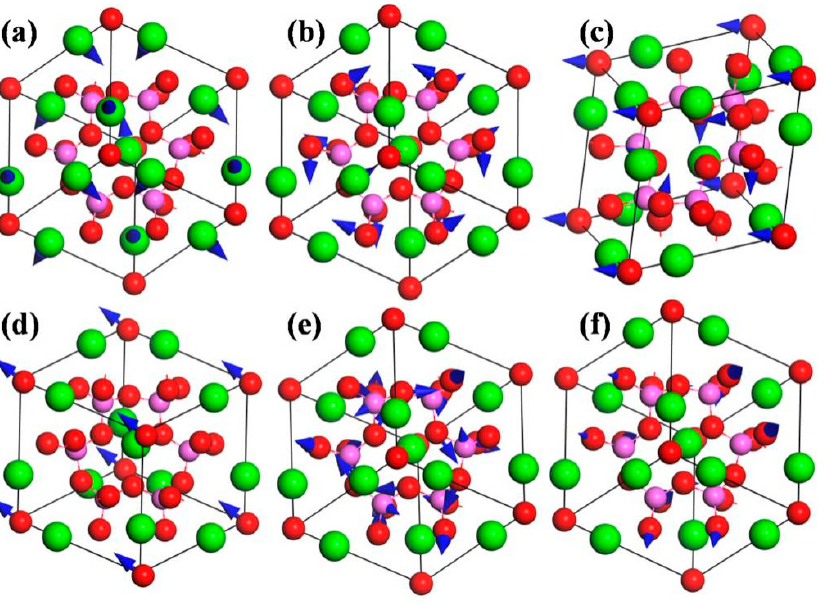
Figure 7. Atomic displacement patterns of CAO. ( a ) E 180 cm − 1 ; ( b ) A 1 270 cm − 1 ; ( c ) T 2 306 cm − 1 ; ( d ) T 2 337 cm − 1 ; ( e ) A 2 1012 cm − 1 ; and( f ) T 2 1046 cm − 1.